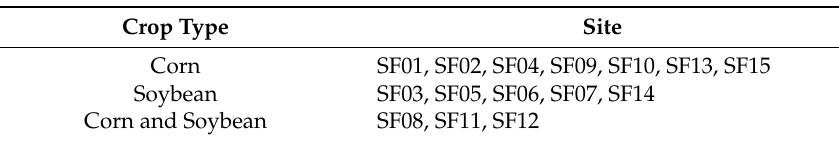
Table 1. Crop type for permanent sites.